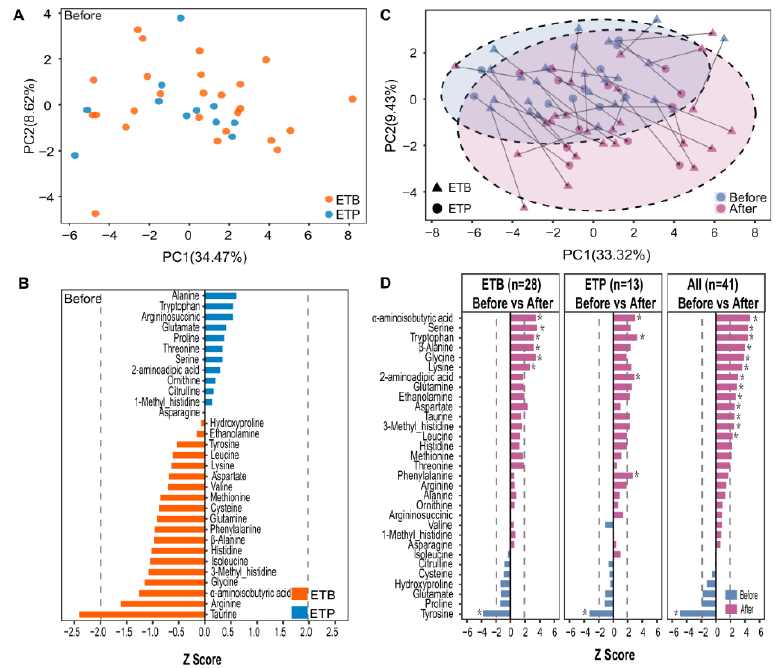
Figure 4. A short-term CR intervention altered the blood amino acids. ( A ) Principal component analysis (PCA) of 41 subjects using baseline blood amino acid profiles. Orange, ETB; blue, ETP. ( B ) Comparison of baseline blood amino acid levels between ETB and ETP subjects; dashed lines indicate the absolute Z score of 1.96 ( P = 0.05); orange and blue bars indicate that the Z-score of blood amino acid was overrepresented in ETB and ETP subjects, respectively; Wilcoxon rank-sum test, P values are transformed to Z-scores to represent enrichment directions. ( C ) Amino acid-based PCA of samples before and after the intervention. Triangle—samples of ETB subjects; Circles—samples of ETP subjects. Arrows indicate paired samples from the same individual. ( D ) Changes in blood amino acid concentrations of ETB subjects, ETP subjects, and all subjects before and after the intervention. Wilcoxon signed-rank test, P values are transformed to Z-scores to represent enrichment directions. Dashed lines indicate the absolute Z score of 1.96 ( P = 0.05). Asterisk (*) indicates the statistical significance at Benjamini–Hochberg (BH) adjusted P < 0.05.